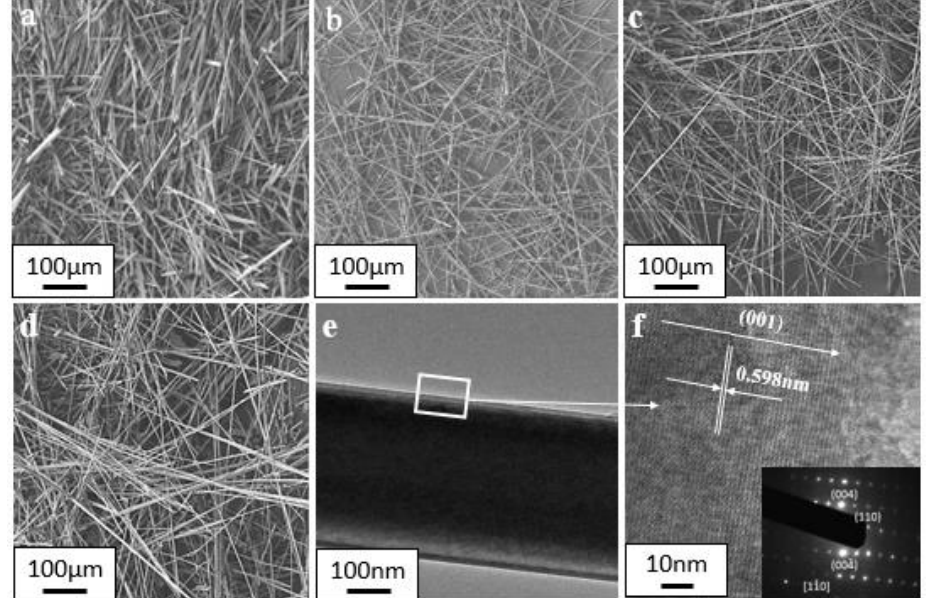
Figure 2. ( a – d ) SEM, ( e ) TEM, and ( f ) high-resolution TEM (HRTEM) images of α-CaSO 4 ·0.5H 2 O whiskers CTAB (cetyl trimethyl ammonium bromide, C 16 H 33 (CH 3 ) 3 NBr) (mol·L −1 ): ( a ) 0; ( b ) 1.0 × 10 −4 ; ( c , e , f ) 9.2 × 10 −4 ; ( d ) 1.5 × 10 −3 .